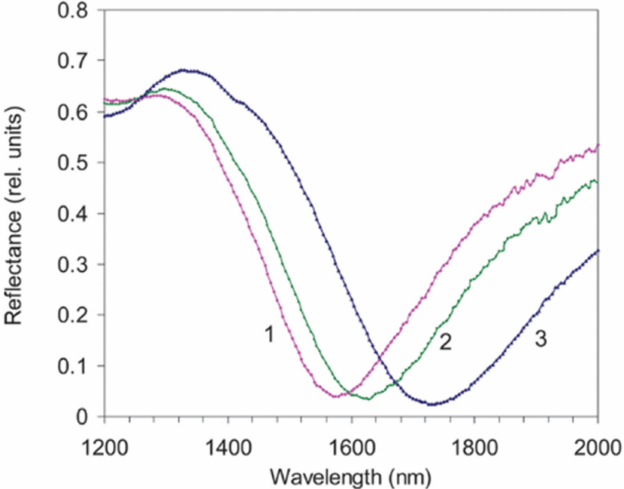
Figure 15. ITO reflectance deposited on a glass substrate ( n = 1.510) for θ = 57.2 ◦ , 55.2 ◦ and 52.5 ◦ , corresponding respectively to the 1,2 and 3 curves. Reproduced with permission from